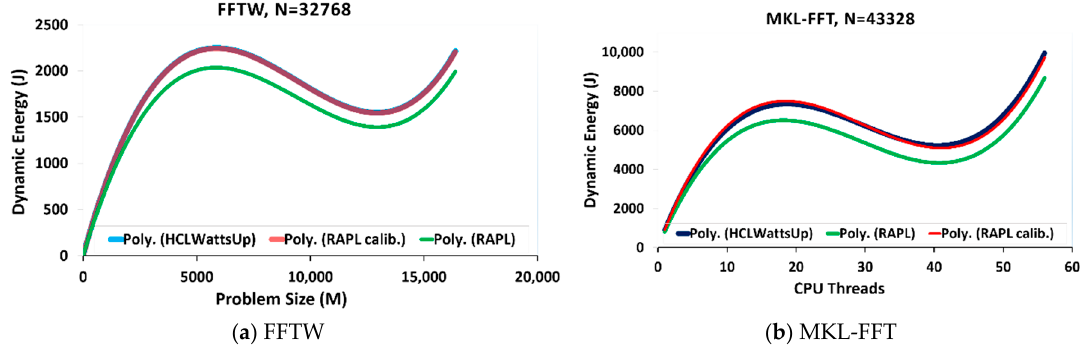
Figure 5. Group B (sets of single energy profile), class same similarity. Group B comprises of sets of energy profiles where only one energy profile is compared with the ground truth. Here, FFTW refers to Fastest Fourier Transform in the West, and MKL-FFT refers to Intel Math Kernel Library kernel for Fastest Fourier Transform.